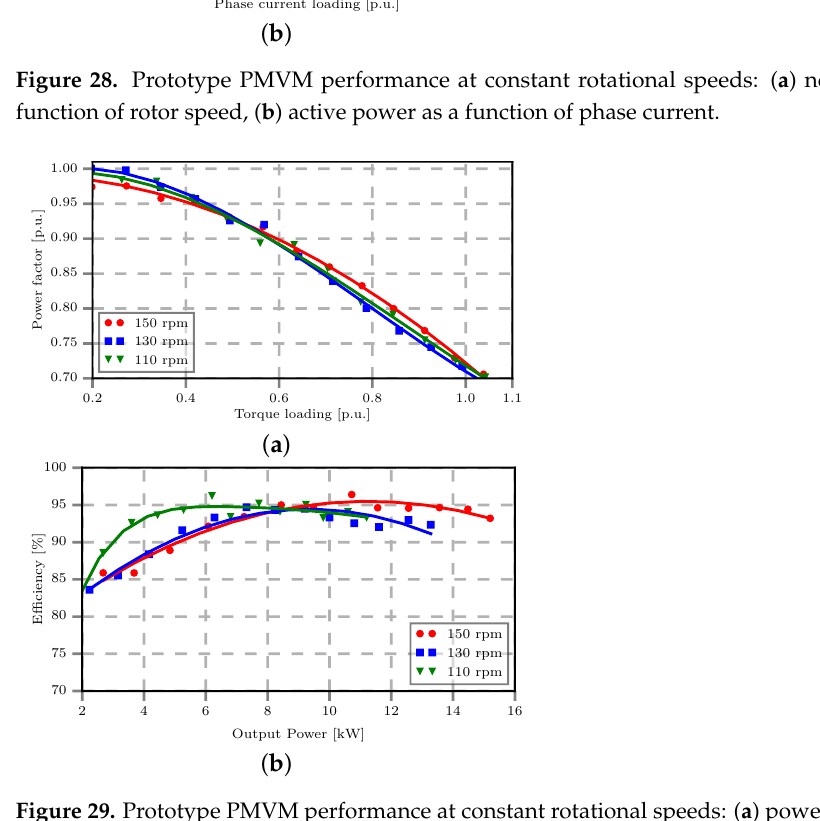
Figure 29. Prototype PMVM performance at constant rotational speeds: ( a ) power factor vs. torque loading, ( b ) efficiency at increasing